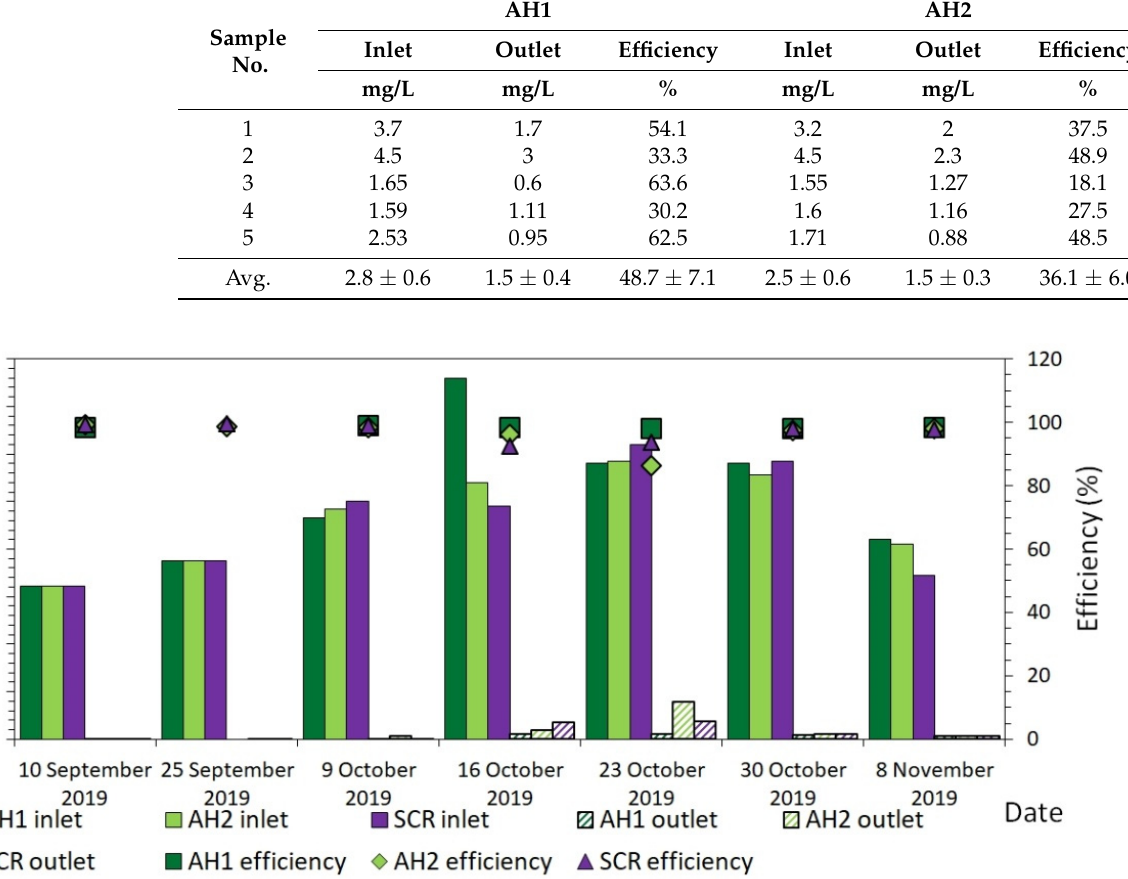
ply to both the surface zone and the bottom of filters). The results obtained in experiment I were comparable to results obtained by Zhang et al. [11] for sorbents (including xylit) with a pH between 7 and 9—about 87%. During experiment II, ammonium nitrogen removal efficiency was much lower, as compared to experiment I. It could result from very low inflow concentrations (grey- water) and some minimum demand for nitrogen incorporated into bacterial cell biomass. 3.2.5. Total Suspended Solids The average values of inflow TSS at preliminary stage and stage I were as follows: 387.6 ± 73.5 mg/L ( n = 9) and 107.3 ± 19.7 mg/L ( n = 4), respectively (Tables 8 and 9). The average efficiencies of TSS removal at the preliminary stage were 42.1 ± 6.2% ( n = 9) for angel hair (AH), and 70.2 ± 8.1% ( n = 8, excluding the measurement of 2 July 2019, as a rough measurement error) for crushed material (SCR). The details related to TSS removal efficiencies at this stage are presented in Figure 10.